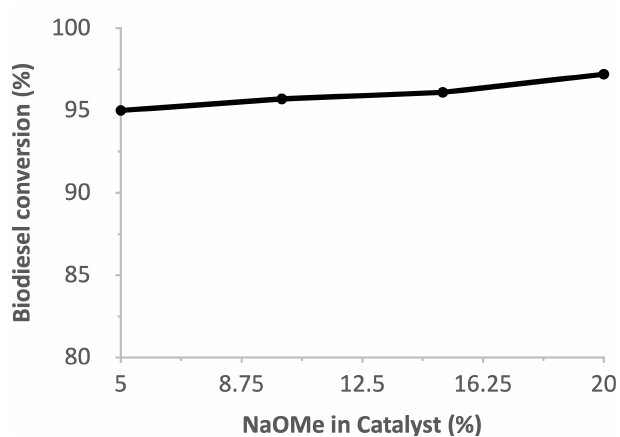
Figure 10. Effect of catalyst amount on biodiesel